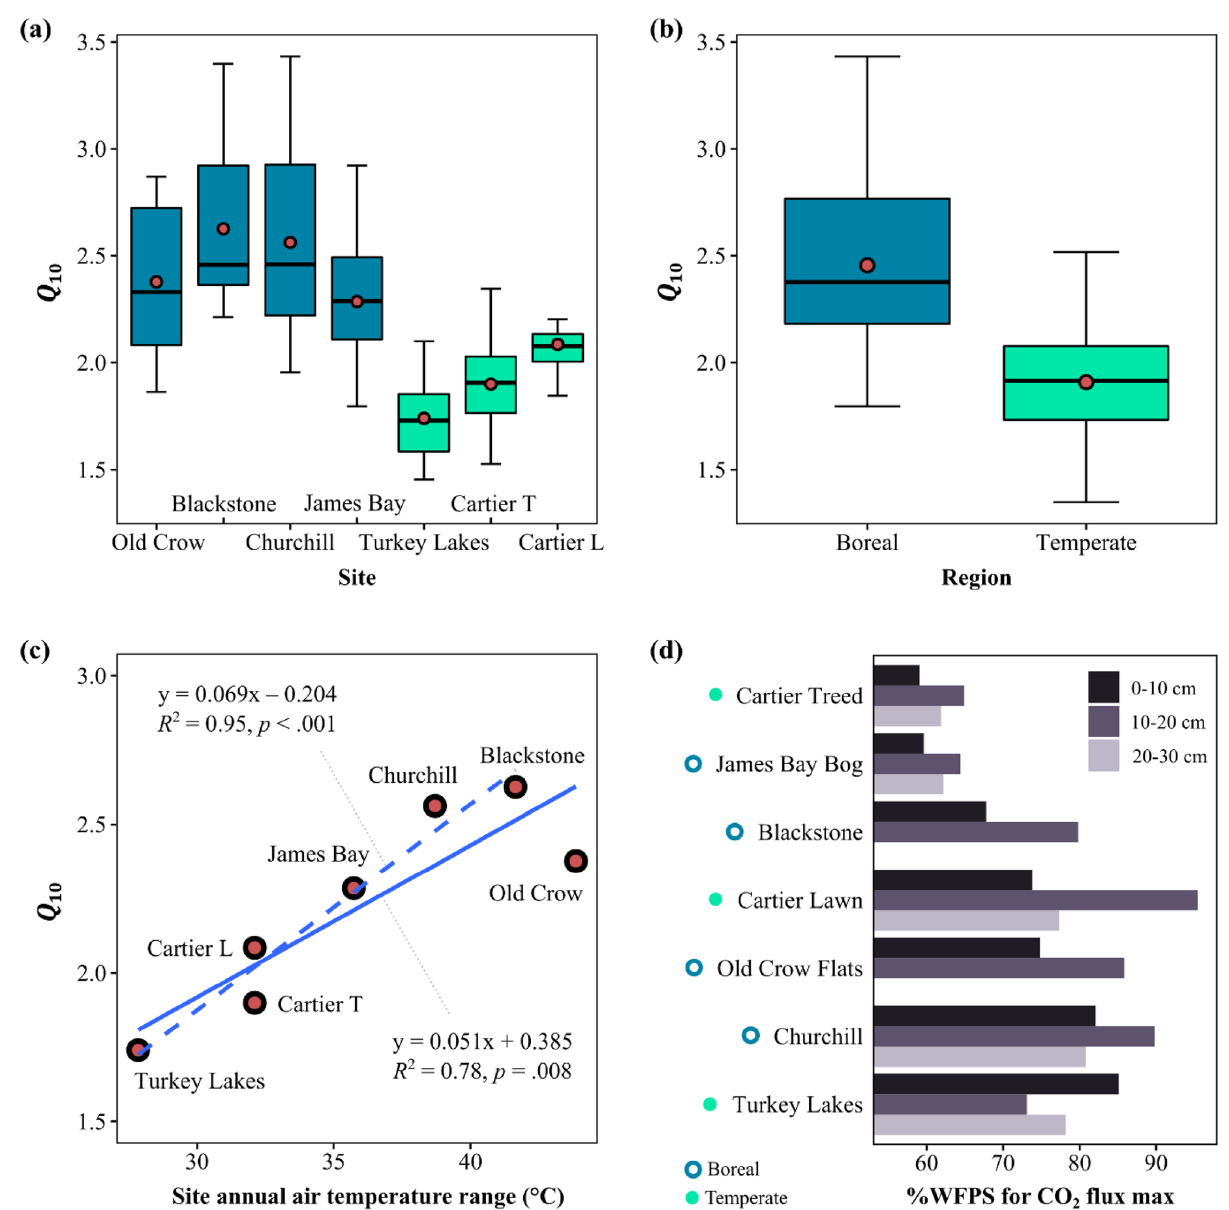
Figure 3. Boxplots of Q 10 values calculated from incubations at different moisture contents and peat depths grouped by peatland site ( a ) and by ecoclimate zone ( b ). Boxes extend from the first to the third quartile with the inside horizontal line corresponding to the second quartile (median). Vertical lines extend to the 1.5 interquartile range of each box. The red circles (in panels a and b) indicate mean ( i.e. , average) Q 10 values. The latter are used in the linear regression analysis against the site air temperatures and the annual temperature range, i.e. , the difference between coldest and warmest month (panel c ; for monthly results, see Supplementary Figure S7). Dashed fitted line in plot ( c ) represents the linear trend without the Old Crow Flats site data. The bar graphs ( d ) compare the optimum moisture levels for CO 2 production by sampling depth and